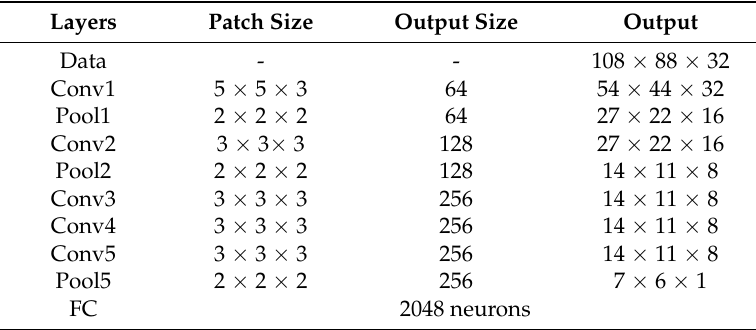
Table 1. Configurations of global network.